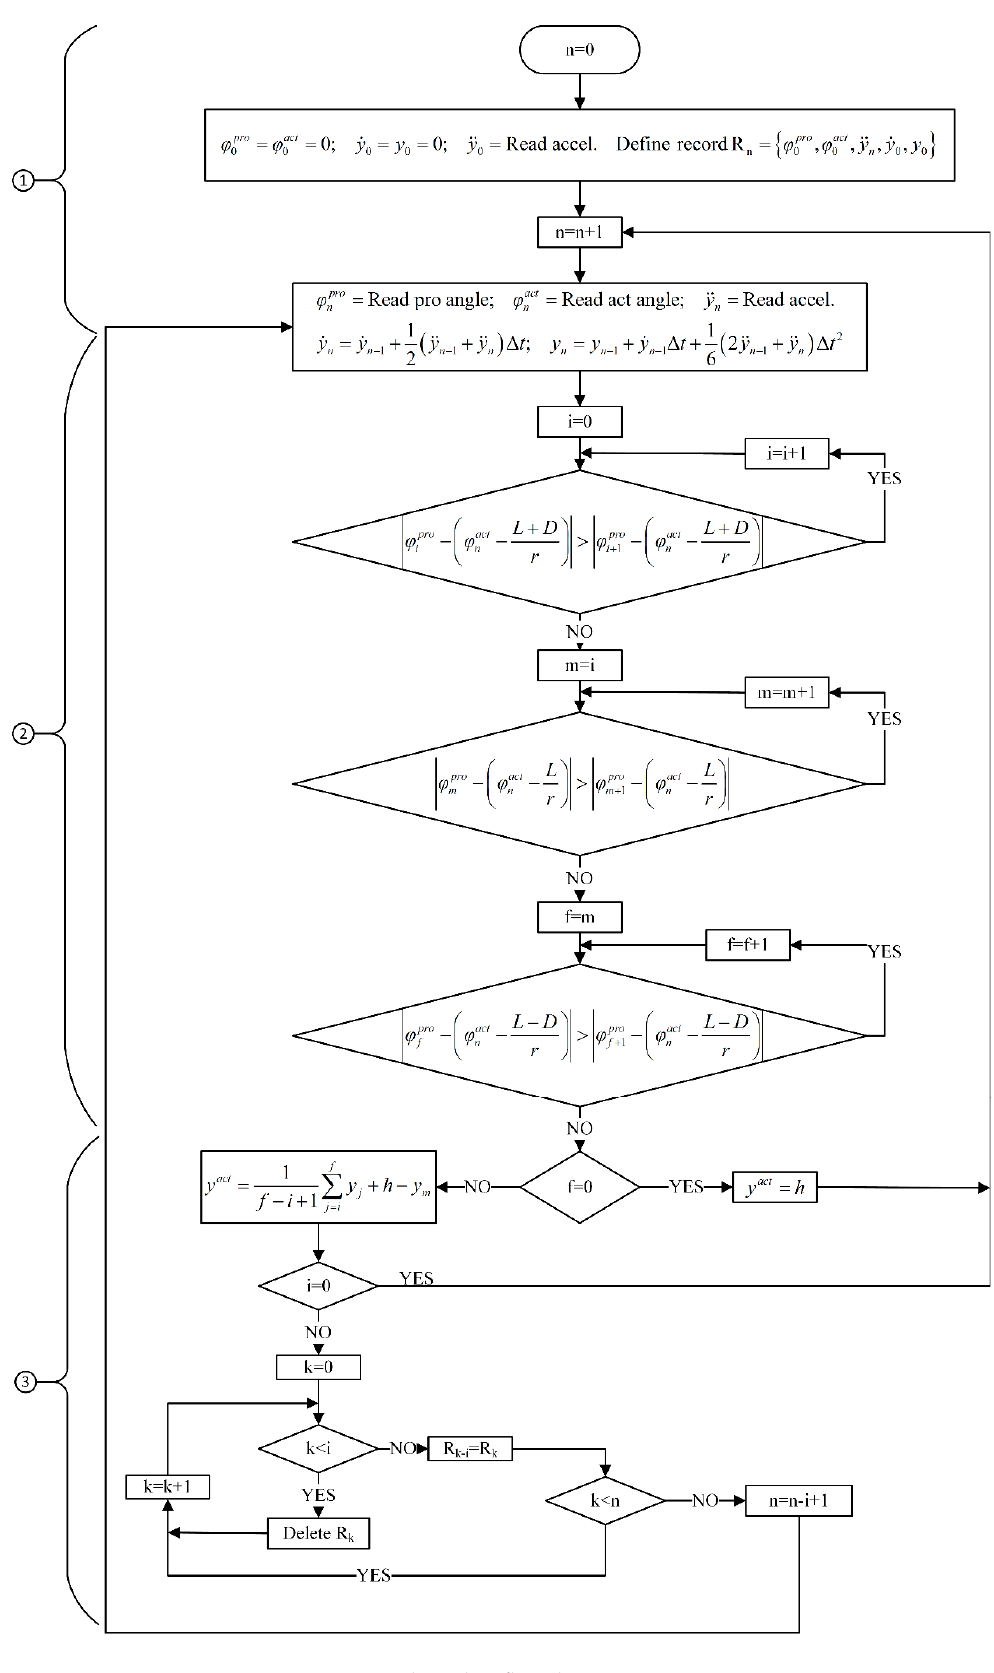
Figure 7. Suspension algorithm flowchart.